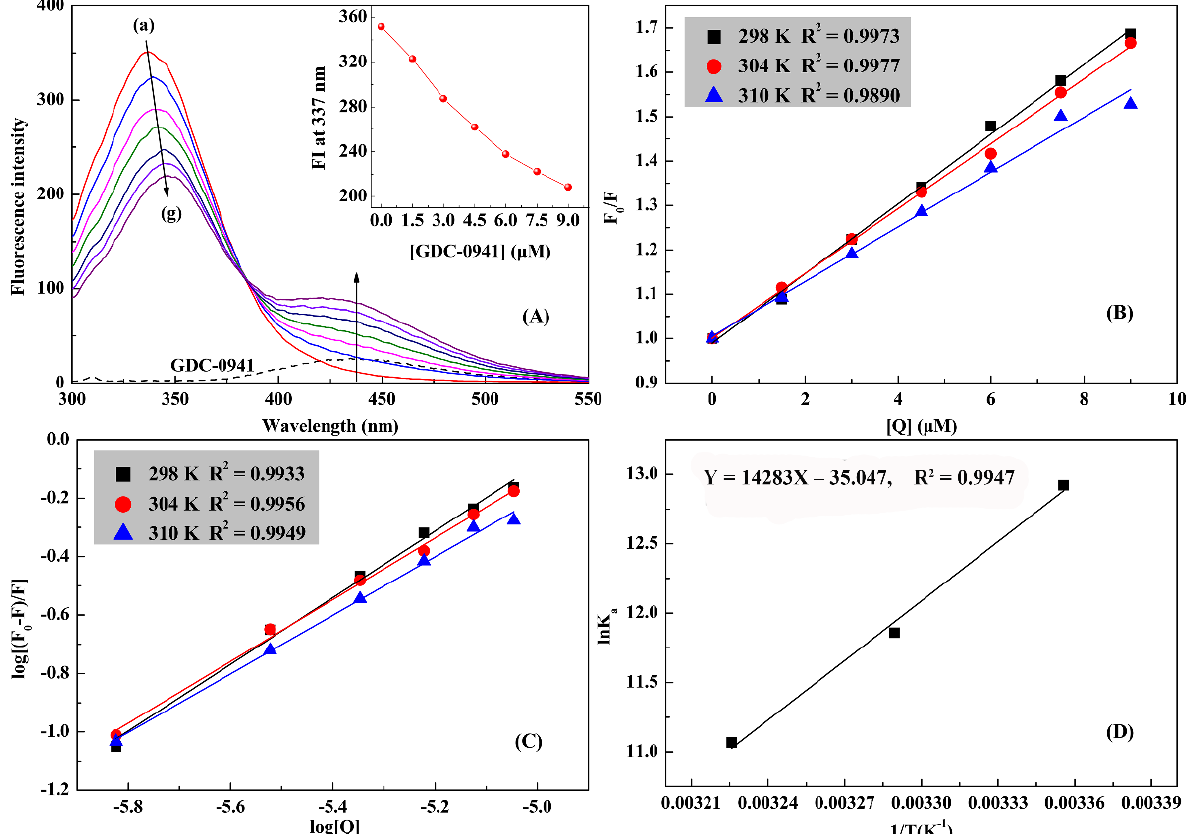
Figure 5. ( A ) Fluorescence emission spectra of HSA (2 μ M) with increasing GDC-0941 concentra- tions (0–9 μ M) at 298 K. The inset shows the fluorescence intensity (FI) of HSA at 337 in different concentrations of GDC-0941. ( B ) The curves of F 0 / F vs. [GDC-0941] at three different temperatures. ( C ) Plots of lg [( F 0 – F )/ F ] against lg [GDC-0941] at different temperatures. ( D ) Van ’t Hoff plot of the HSA–GDC-0941 complex system.